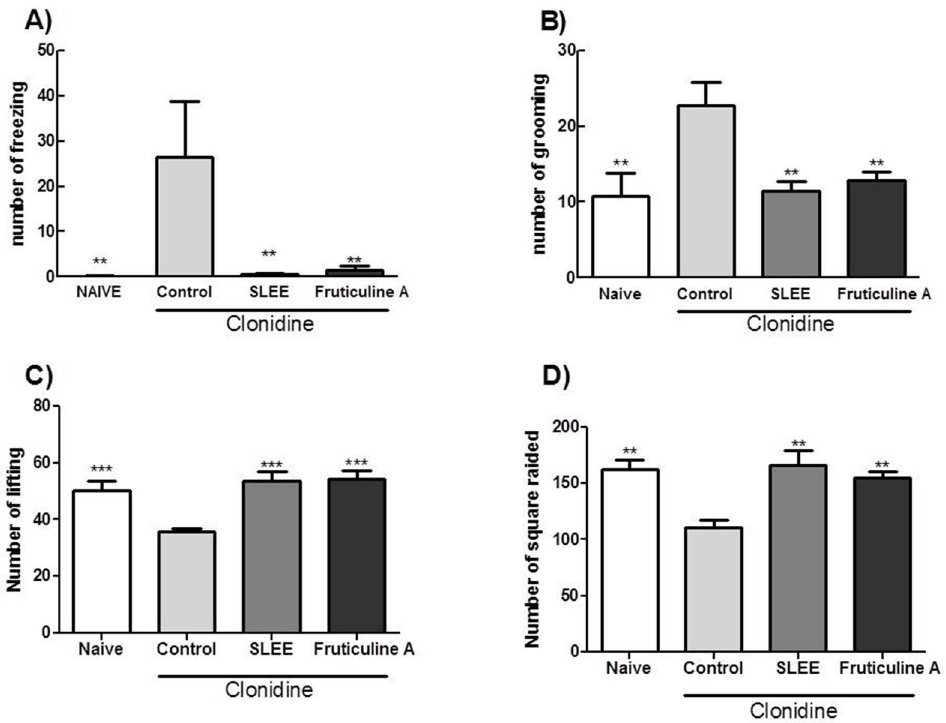
Fig 5. Effect of fruticuline A and SLEE during the open field test in clonidine-induced depressive mice. The animalswere treated with 8 mg/kg (i.p.) of clonidinefor 7 days, and the naive group receivedsaline (i.p.). From the fifth to seventh days, animalsreceivedan p.o. of saline(naive and control), SLEE (100 mg/kg) and fruticulineA (3 mg/kg.). On the eighthday, the numberof freezing (A) and grooming(B) animalswere assessed, indicatingemotionality. Locomotoractivity was evaluatedby the number of licking animals(C) and squaresinvadedby animals (D). The bars express the mean ± SEM (n = 6) comparedwith control ( ** P < 0.01 and *** P <